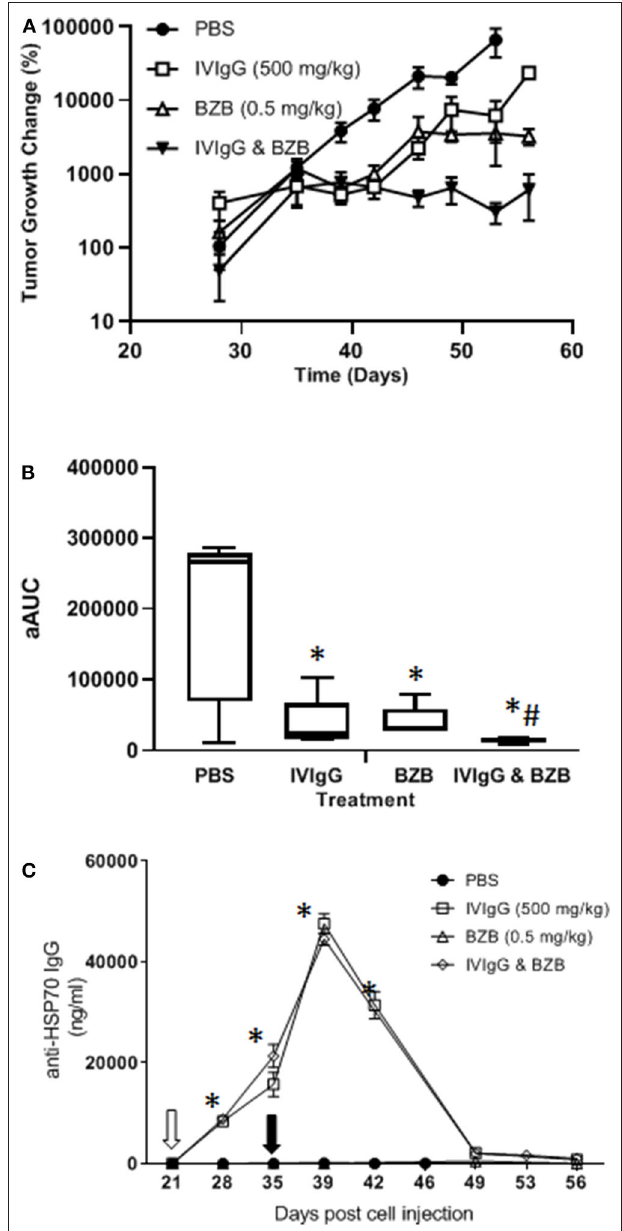
FIGURE 8 | The IVIgG and BZB combination reduces myeloma disease burden and leads to high titers of anti-HSP70 IgG in mouse serum. (A) SCID mice injected with MM1.S cells carrying a luciferase expression cassette were monitored by IVIS imaging following a weekly dose of IVIgG for 3 weeks alone or IVIgG in combination with BZB twice per week for 2 weeks. The difference in tumor growth change (%) is shown. (B) Overall anti-tumor activity measured as the area under the curve (aAUC) over time is shown. (C) Serum titers of anti-HSP70 IgG in mice treated as above. * denotes p < 0.05 compared to the PBS control using the T -test in the above, while # denotes p < 0.05 compared to the PBS control using the Wilcoxon rank sum